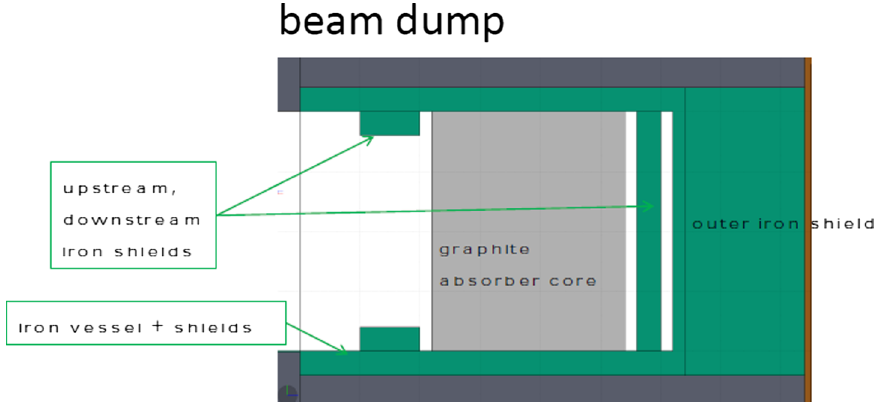
FIG. 28. Beam dump layout used in simulation. Graphite beam dump in grey and several iron shields in